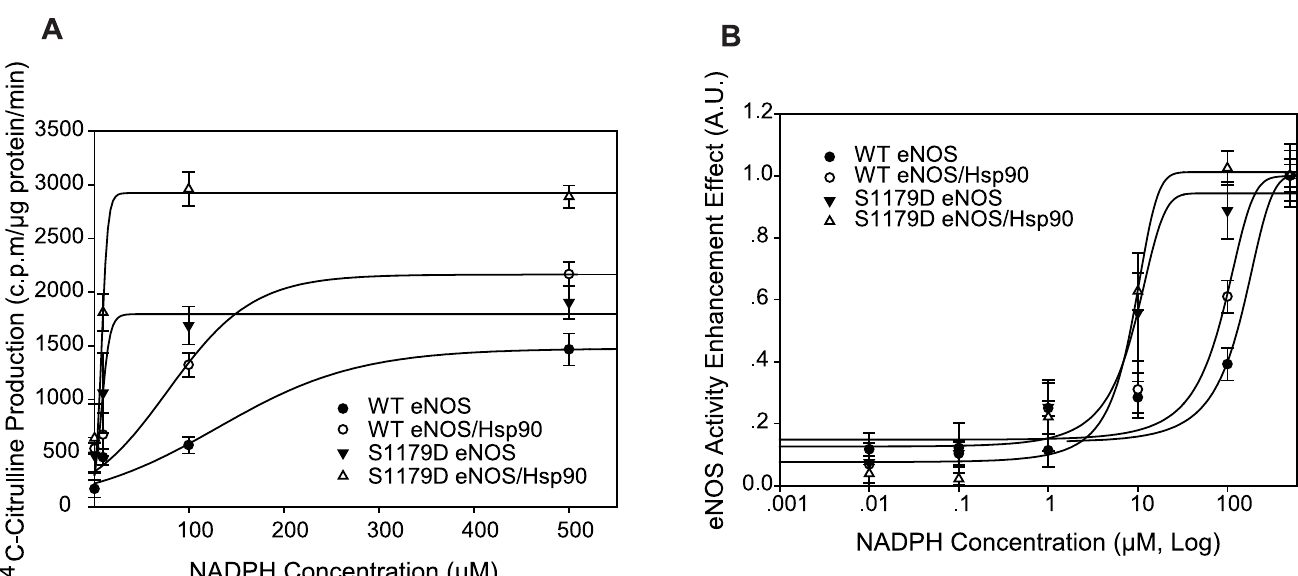
Fig 2. Hsp90 enhanced WT eNOS but not S1179D eNOS affinity to NADPH. (A) Hsp90 augmented both WT eNOS and S1179D eNOS activity in the presenceof NADPH. The effect of Hsp 90 on enzymatic activity of WT eNOS and S1179D eNOS was assayed by monitoring the conversionof L- 14C-arginineto L-14C-citrulline in the presenceof indicatedconcentration of NADPH (n = 5). (B) NADPH-eNOS activity dynamicassay showedthat Hsp90 enhanced eNOS affinity to NADPH in WTeNOS. In contrast, mutation of S1179DsignificantlyenhancedeNOS affinity to NADPH in the absence and presenceof Hsp90 comparedto their control (EC50, P < 0.05;n = 5).